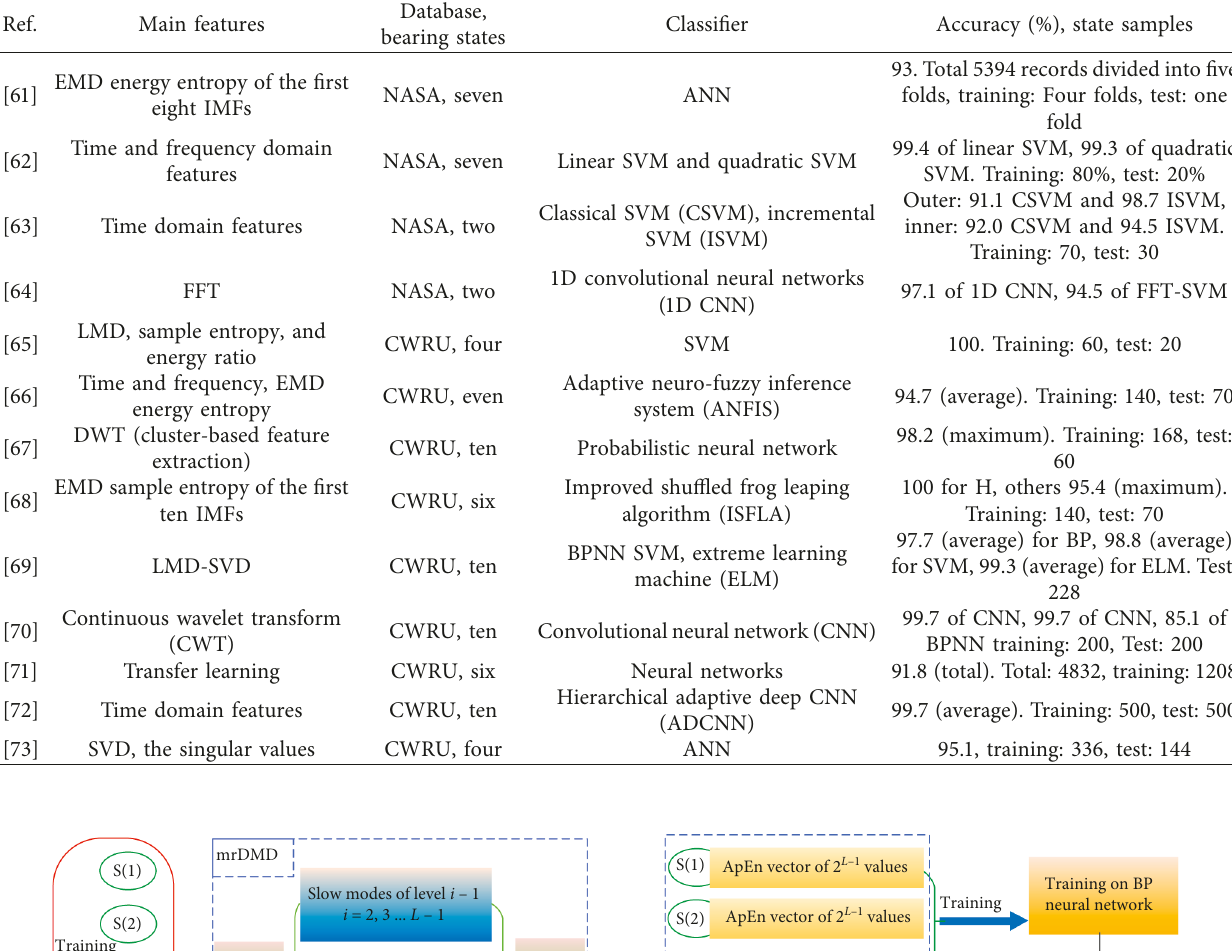
Table 1: Fault diagnosis methods and performance for NASA and CWRU signals based on SVM and ANN. Ref.